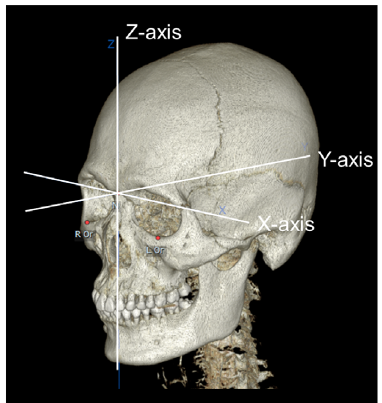
Figure 1. The three-dimensional coordinate system (X, Y, Z) used in this study.